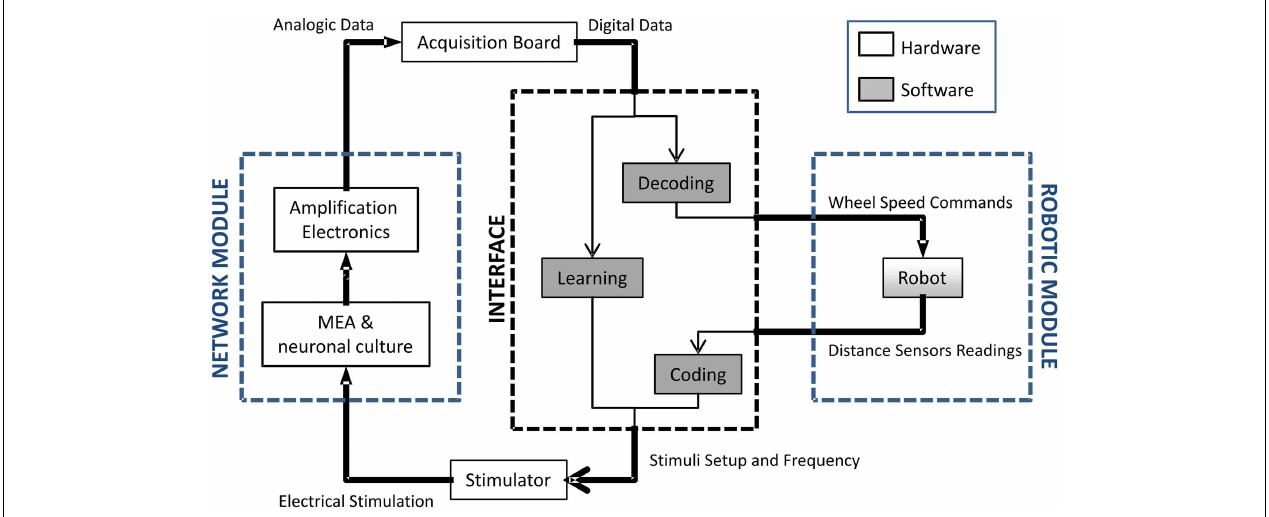
FIGURE 1 | Block diagram of the neuro-robotic architecture. From left to right: (i) the network module, constituted by a network of living neurons coupled to a micro electrode array; (ii) a computer which hosts the developed software tool (i.e., HyBrain2) which manages the communication between the biological and the artificial part; (iii) the robotic module composed by a robot, either real or virtual, with sensors and actuators navigating into a circular arena with